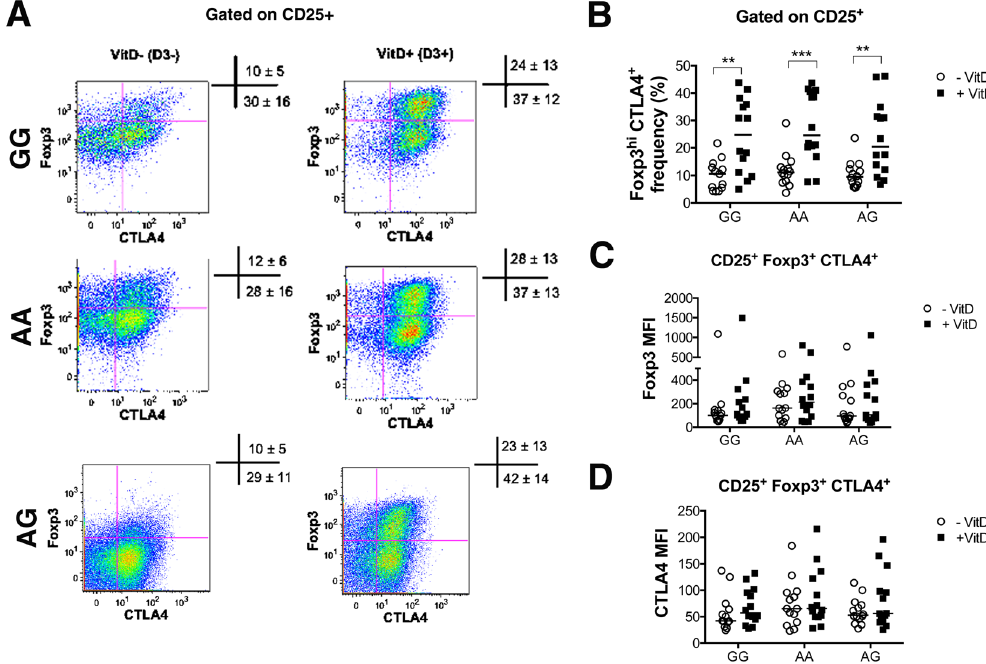
Figure 6. GG, AA and AG individuals show similar frequencies of Tregs. CD4 + CD25 − T cells were activated in vitro with aCD3 antibody and CHO-CD80 cell line in the presence or absence of 1,25(OH) 2 D 3 for 5 days. ( A ) Representative flow cytometry plots showing expression of Foxp3 and CTLA4 on CD25 + cells across genotypes in the presence (VitD + ) and absence (VitD − ) of 1,25(OH) 2 D 3 . Values in cross symbols represent the mean frequency (%) of Foxp3 hi CTLA4 + and Foxp3 int CTLA4 + plus/minus standard deviation across genotypes in all samples (n = 14 per group). ( B ) Frequency of Foxp3 hi CTLA4 + in CD25 + cells in the presence and absence of vitamin D. ( C,D ) Foxp3 and CTLA4 median fluorescence intensity (MFI) on Foxp3 hi CTLA4 +